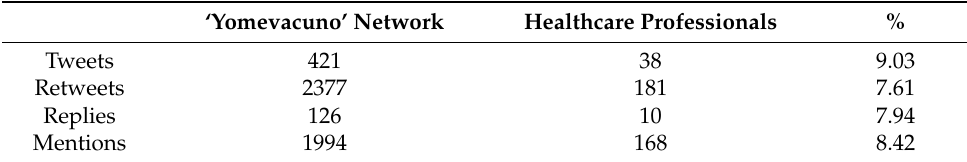
Table 1. Messages from healthcare professionals in #yomevacuno network.